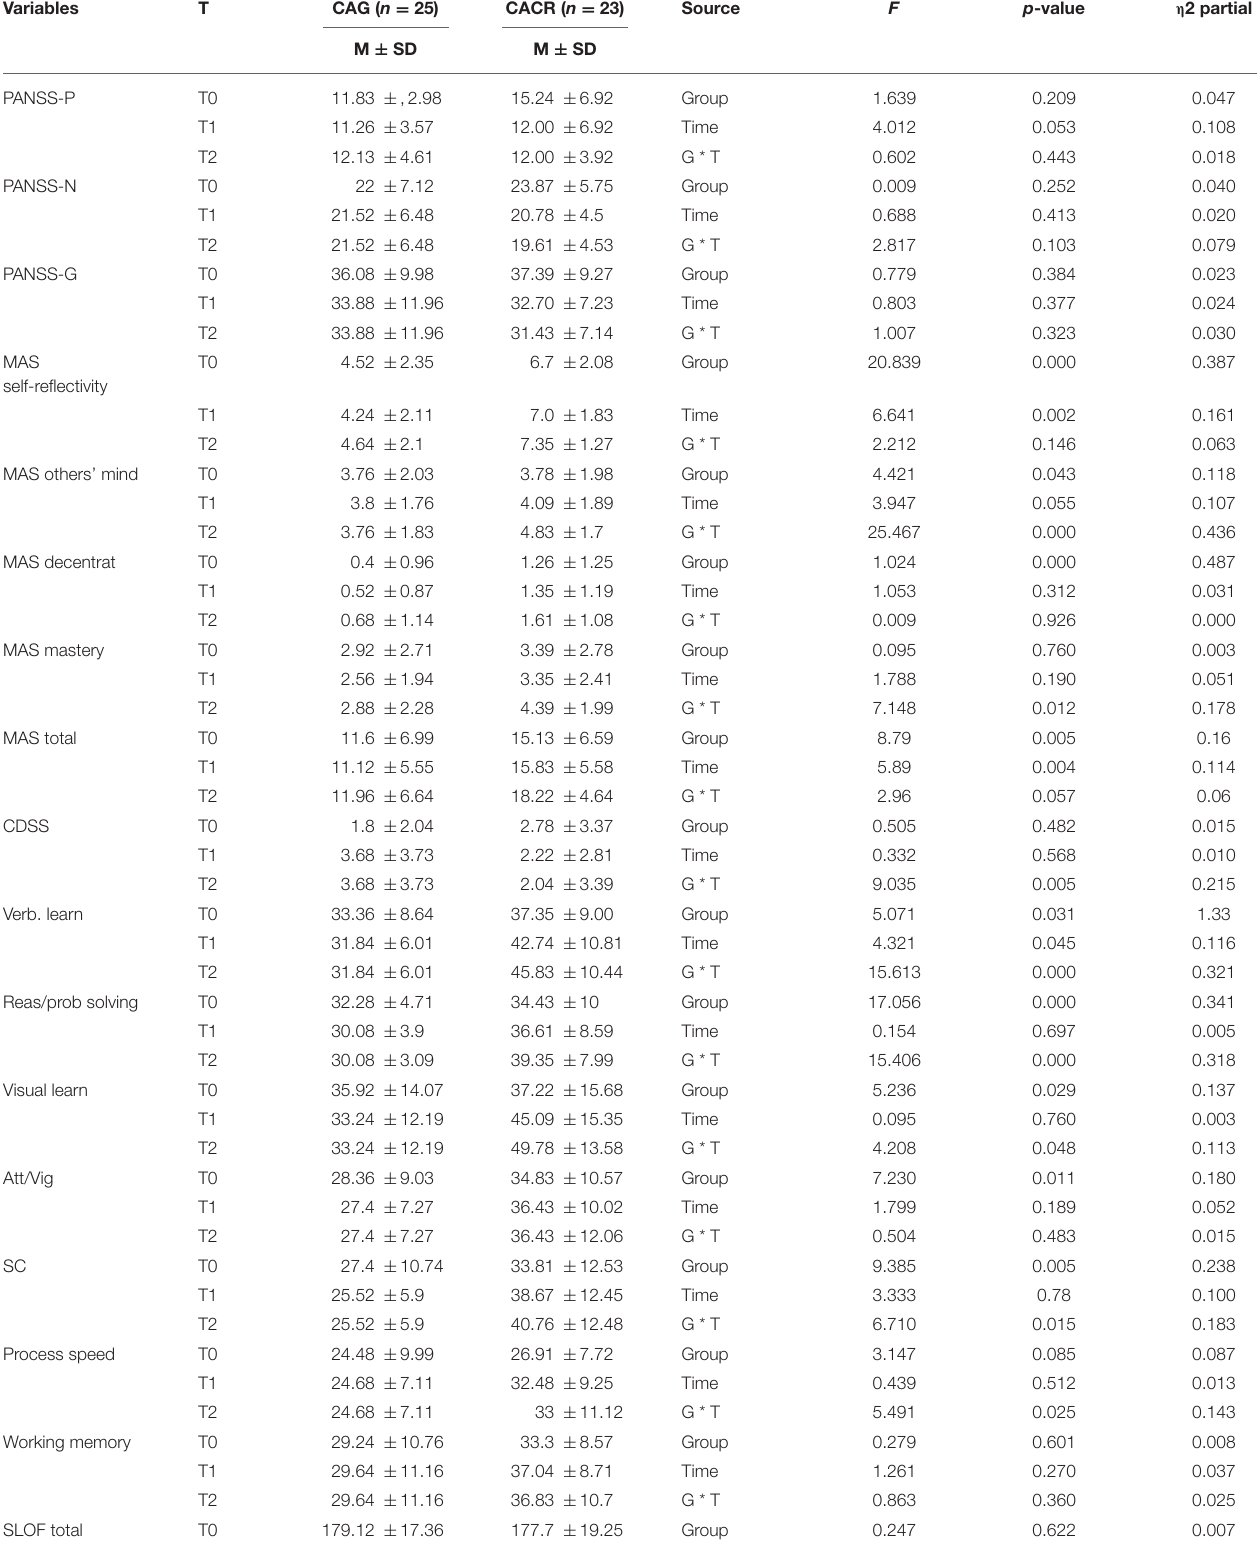
TABLE 4 | Scores for the neuropsychological, clinical, and functional outcomes at baseline and post-intervention. Variables